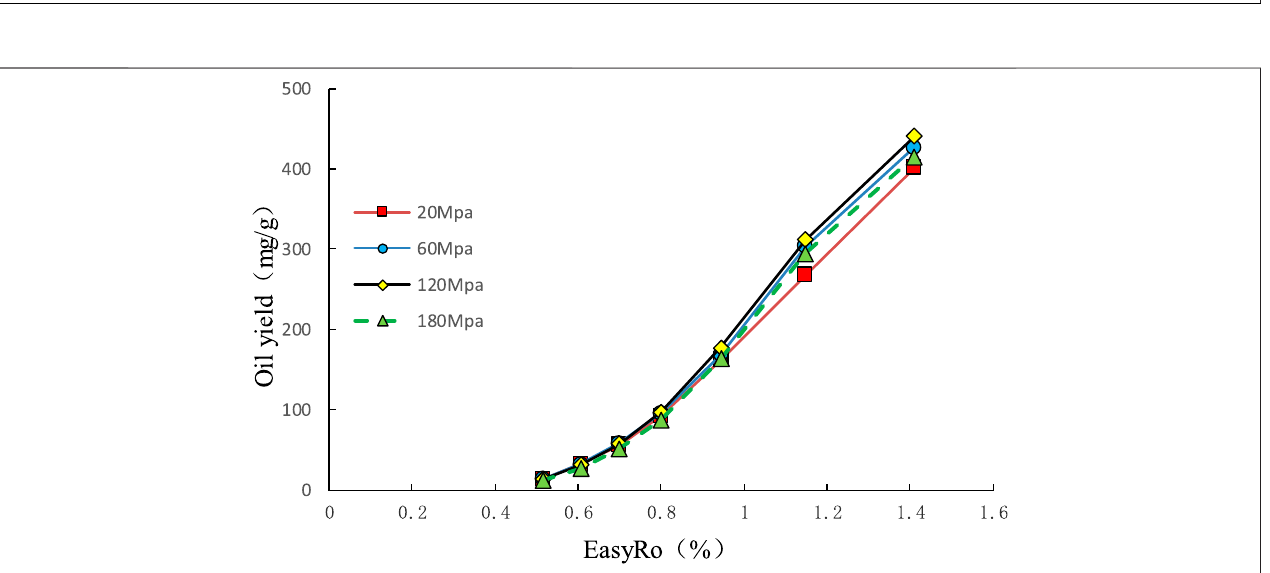
FIGURE 10 | Comparison of cumulative oil yields of sample 2,911 under different pressure conditions.